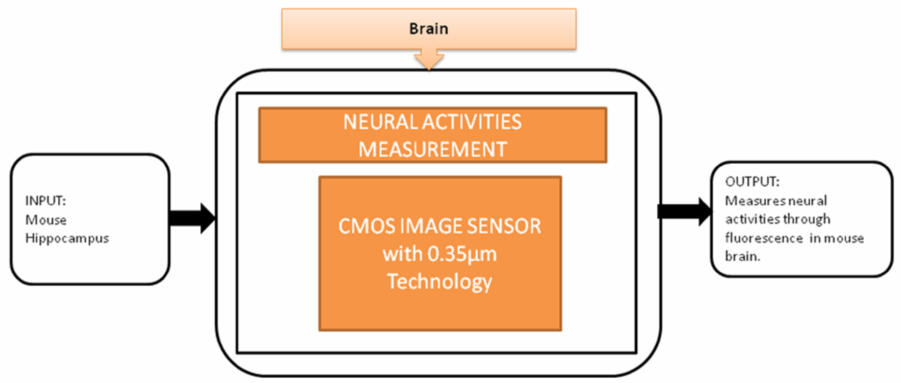
Figure 18. Implantable CMOS image sensor for neural activities measurement.